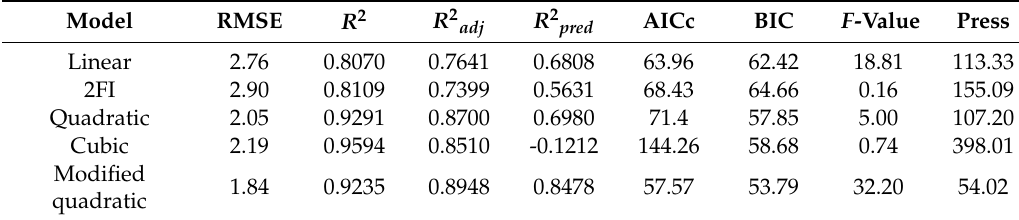
Table 13. Statistical comparison between the five